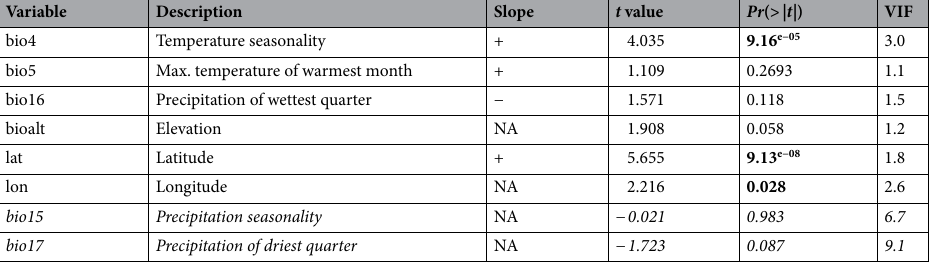
Fig. 3B; Table 3) and L. villosissimus vs. L. semotus (Schoener’s D = 0.20; Fig. 3C; Table 3). The null hypothesis of niche equivalency was rejected in all pairwise species comparisons, revealing that niches were not identical